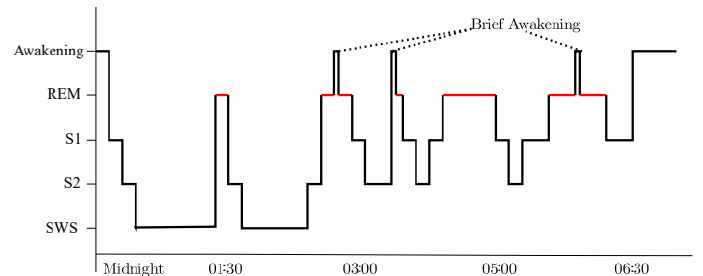
Figure 1. An example of a hypnogram with 6.5 h of sleep. Adapted from https://commons.wikimedia.org/wiki/File:Sleep_Hypnogram.svg (accessed on 3 January 2022). PSG recordings include combinations of EEG, EOG, respiratory signals, and EMG signals. The sleep stage is determined every 30 s, and the signals generated, during sleep.